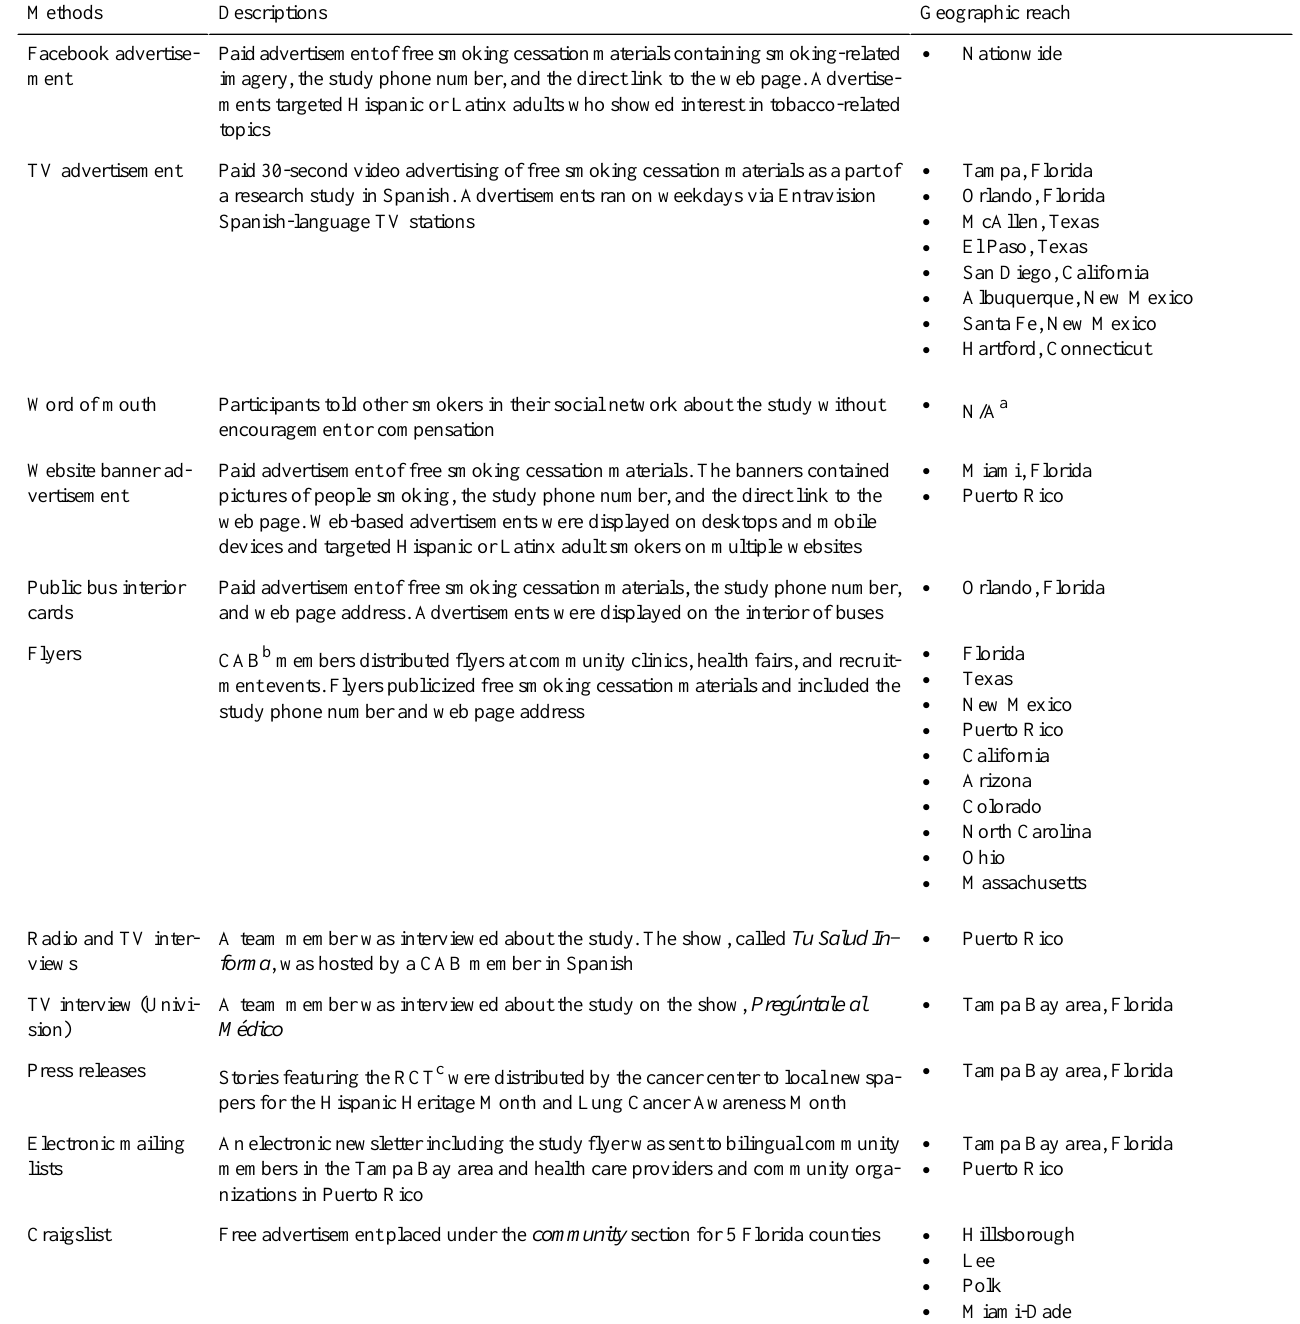
Table 1. Recruitment